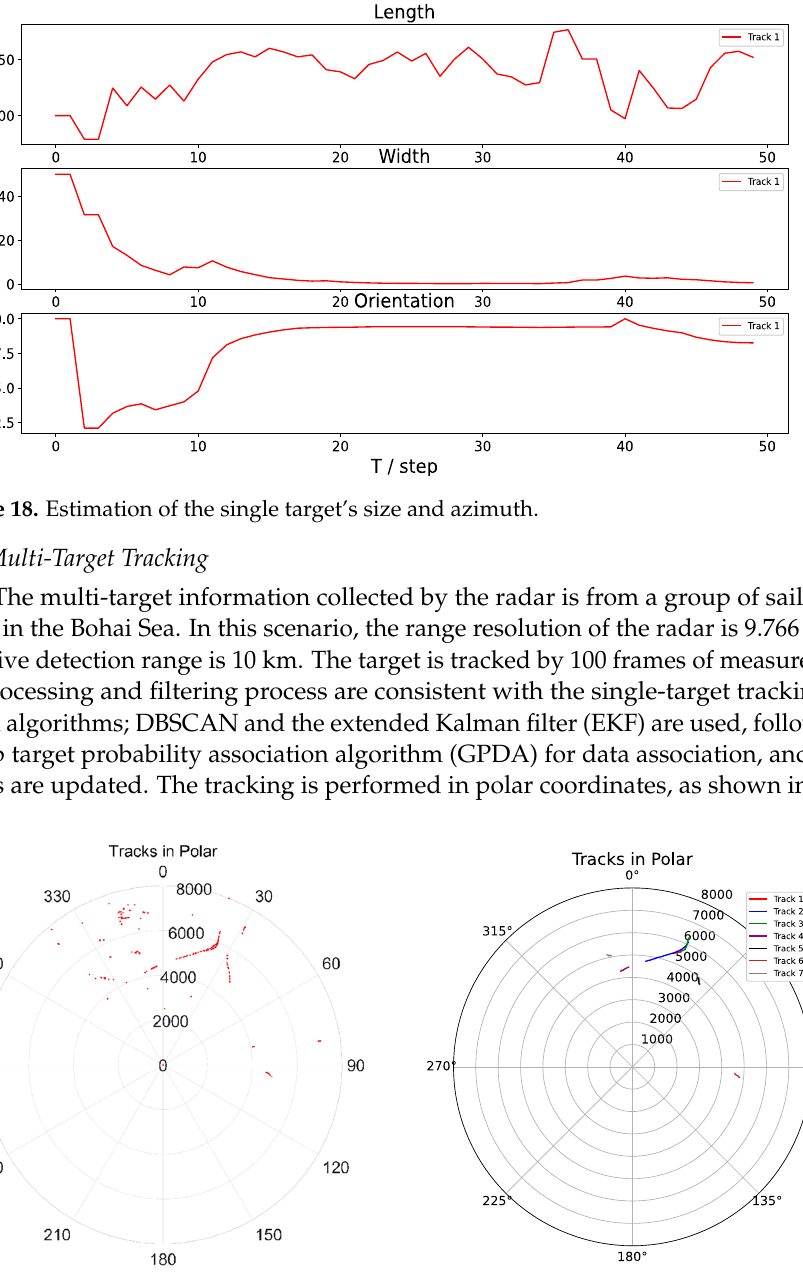
Figure 17. Single-target velocity estimation (CMKF-REMTT).